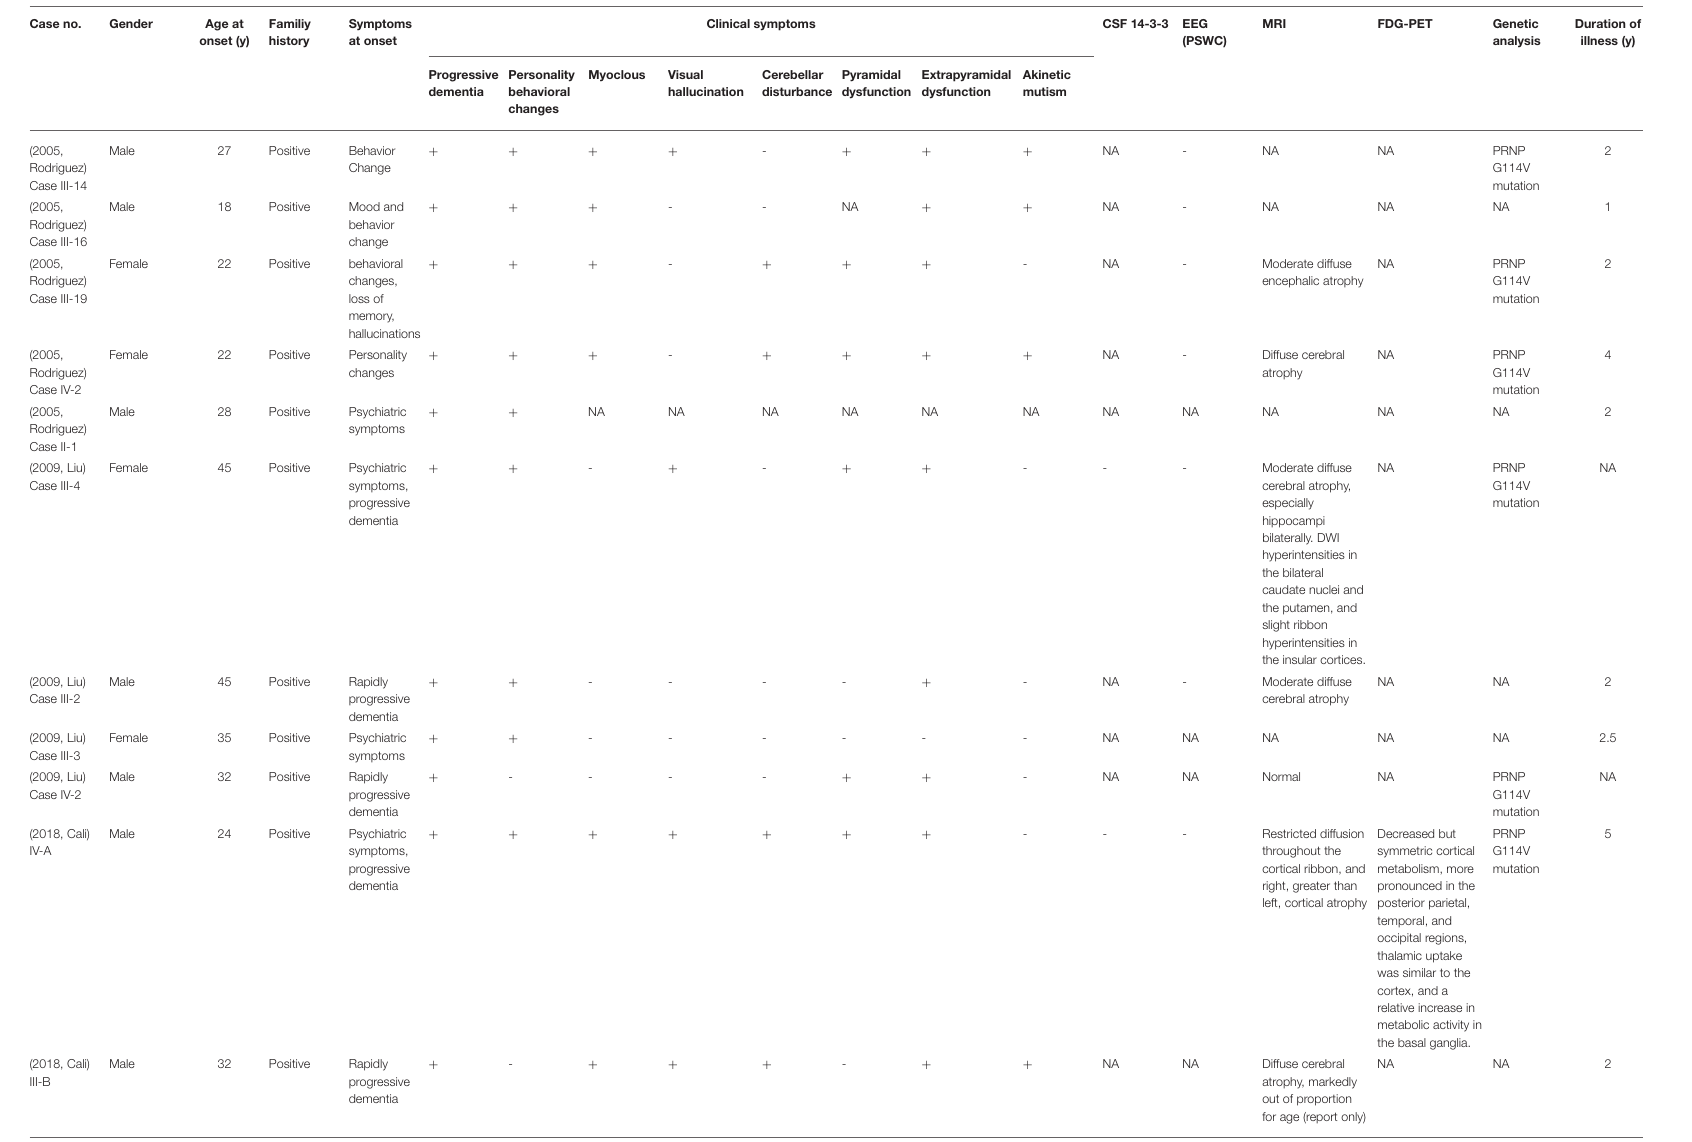
TABLE 4 | Features of the 15 reported cases with PrP G114V mutation.